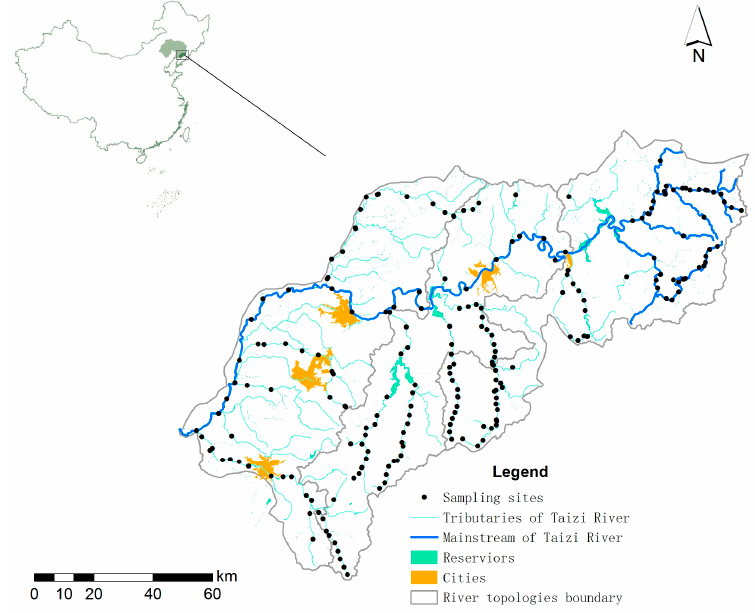
Figure 2. Sampling locations in the Taizi River Basin, northern China.